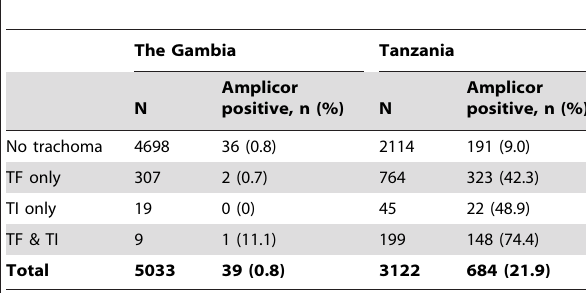
Table 2. Correlation between disease and ocular C. trachomatis infection in children aged 0–5 years.